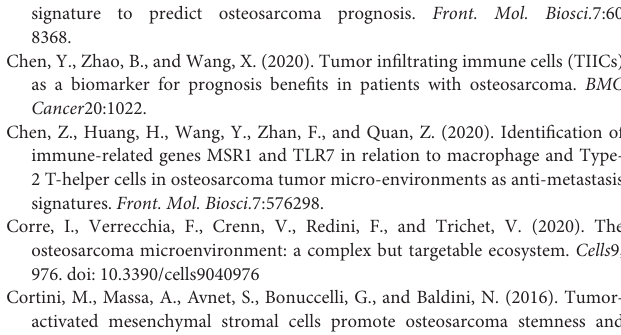
Supplementary Figure 1 | Consensus clustering for tumor-infiltrating immune cells. Consensus matrixes of the samples in the training cohort for each k ( k = 2–5), displaying the clustering stability using 1000 iterations of hierarchical clustering. Supplementary Figure 2 | The prognostic prediction ability of each gene in the nine-gene signature tested using the Kaplan–Meier estimator in the training (A) and validation (B) cohorts. The two-sided log-rank test measured the differences between the high and low expression level groups. P -value < 0.05 was considered as significantly. Supplementary Figure 3 | GSEA conducted using HALLMARK collection. GSEA: Gene Set Enrichment Analysis; NES: Normalized Enrichment Score; NOM: Nominal; FDR: False Discovery Rate; A gene set with | NES | > 1, NOM p -value < 0.05, and FDR q -value < 0.25 was considered significantly enriched. Supplementary Figure 4 | Profiles and correlation analysis of the 22 TICs in OS tumor samples of the training cohort. (A) The distribution of 22 TICs in high- and low-risk OS patients in the training cohort, which are displayed in the form of bar plots. (B) The inner correlations between 22 TICs, which are shown in the form of a heatmap and performed via the Pearson coefficient. P -value < 0.05 was considered as significantly. TIC: tumor-infiltrating immune cell; OS: osteosarcoma. Supplementary Table 1 | Differentially expressed genes identified between two ICI clusters ( p -value < 0.05 and log2| fold-change| > 0.2). Supplementary Table 2 | Potential prognostic genes identified in the training cohort ( p -value < 0.05). Supplementary Table 3 | Correlations that determined between the nine-gene signature and the 22 TICs by the Spearman coefficient. Supplementary Table 4 | The prognostic ability of 22 TICs tested by the Kaplan-Meier